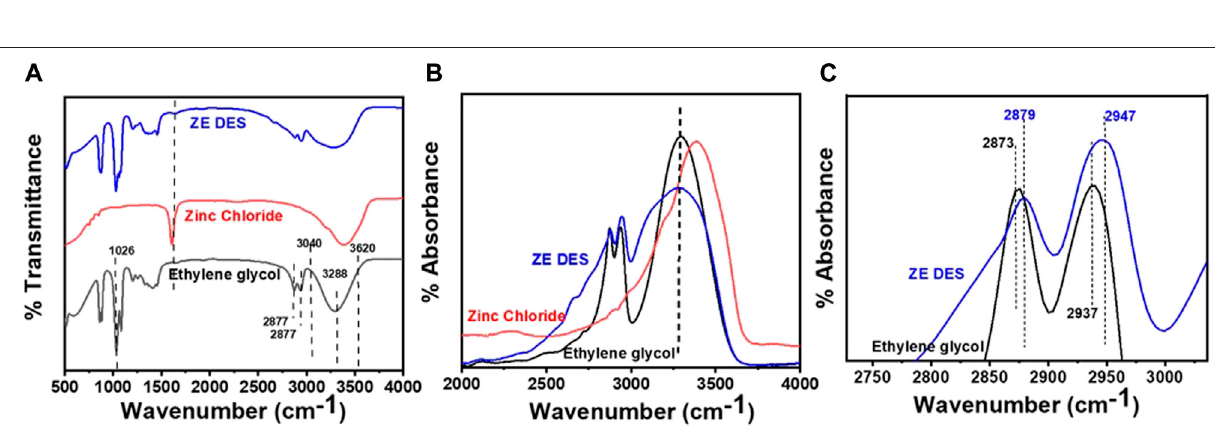
2 and EG was chosen